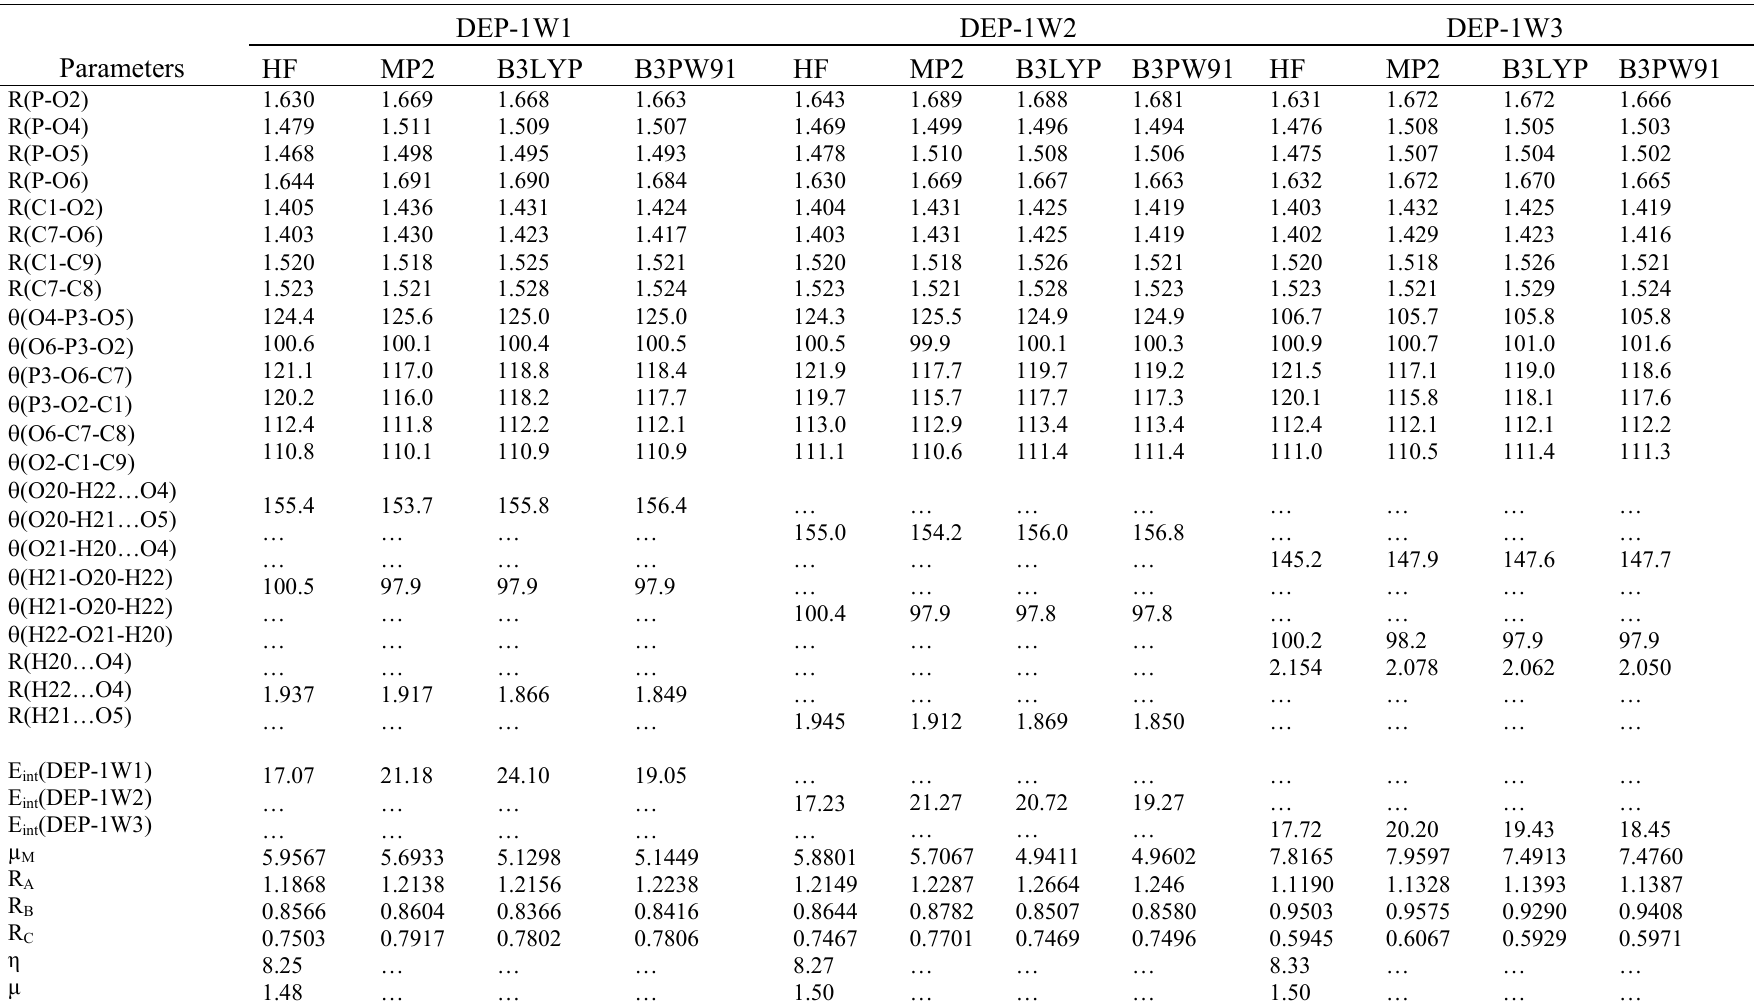
Table 5 Optimized geometrical parameters (bond length in Å, bond angle in degrees), rotational constants R Debye), chemical potential µ (in eV) and chemical hardness η (in eV) for DEP-1water